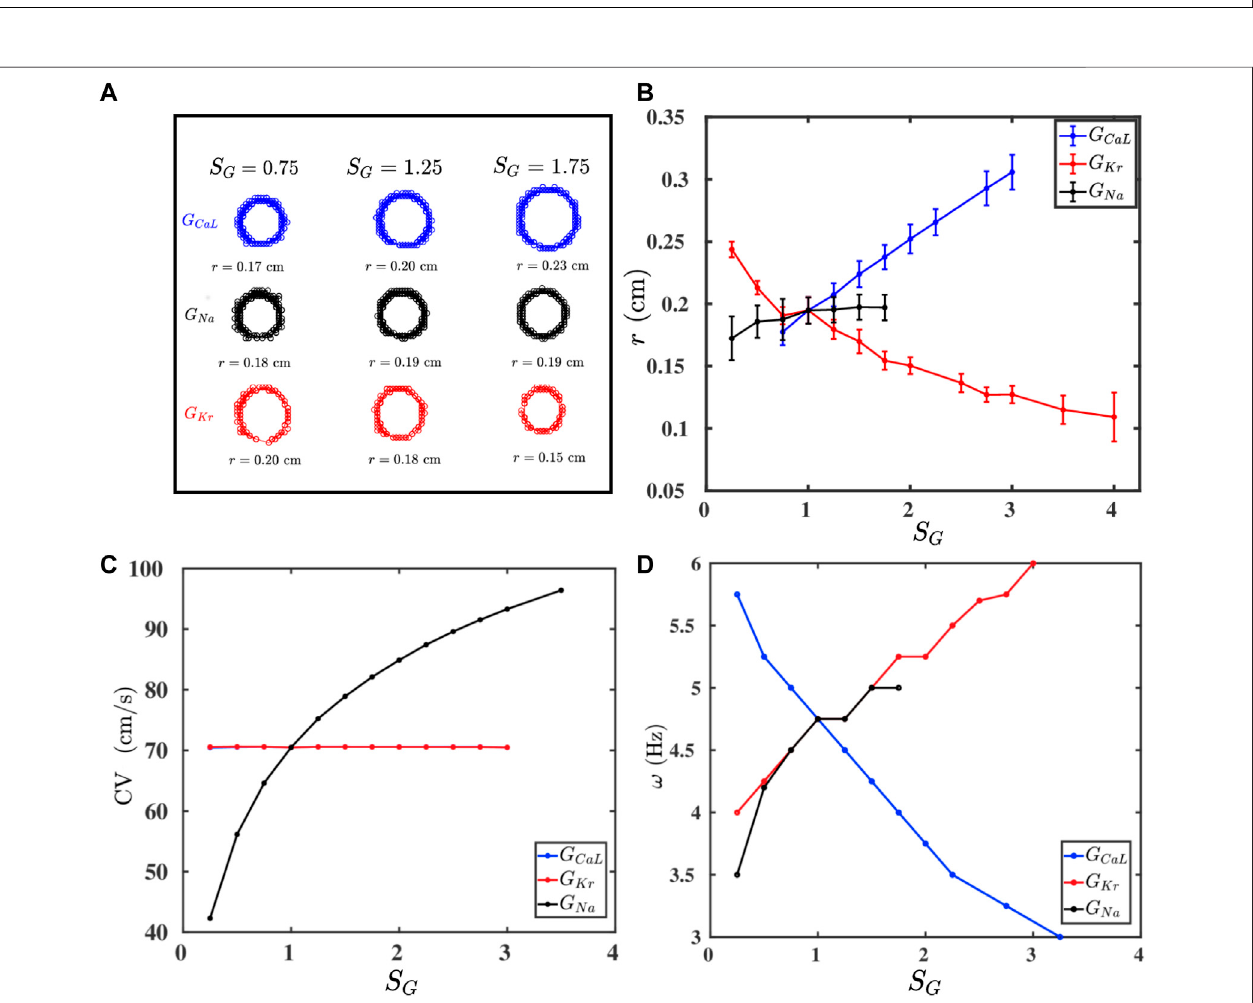
FIGURE2|(A) Tracesofthetiptrajectoriesofaspiralfordifferentvaluesofconductancesofthreeionchannels: G CaL (blue), G Na (black),and G Kr (red);thecolumns indicate S G ( Eq.3 ),whichmultipliesonlytheconductancethatlabels arow(allotherconductances areheldat theircontrol valuesaswemove alongarow). (B – D) :Plots versus S G of, respectively, r , CV, and ω (see text), for all these three conductances; one-standard-deviation error bars are shown for r .